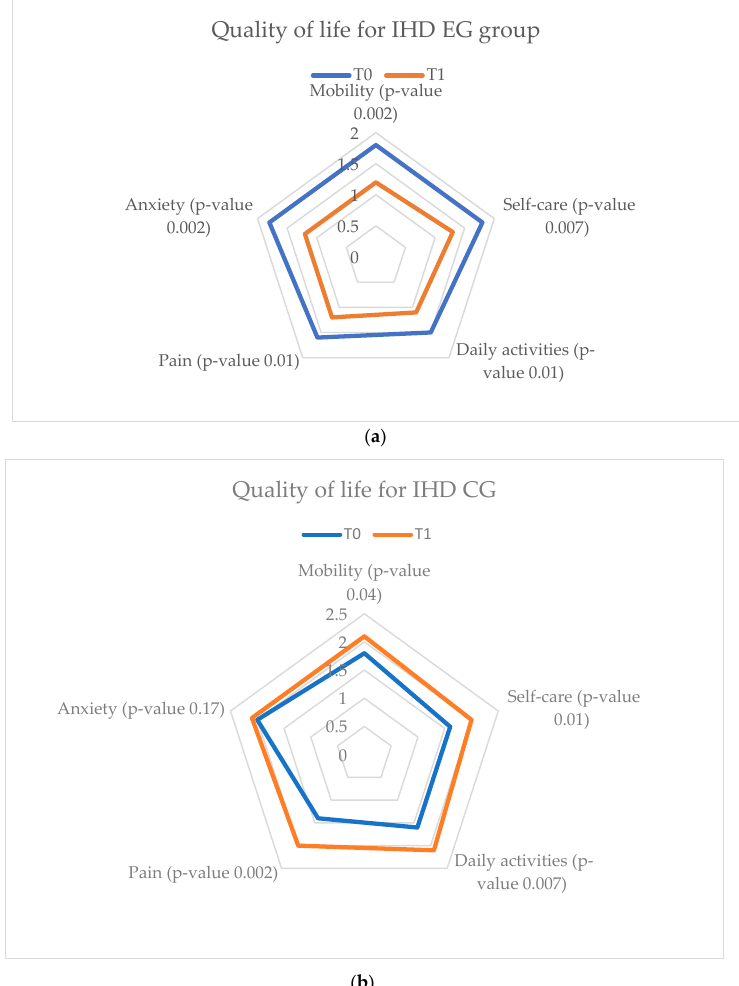
Figure 13. EuroQol-5D results parameters for the ischemic heart disease study group. ( a ) Quality of life for IHD EG. ( b ) Quality of life for IHD